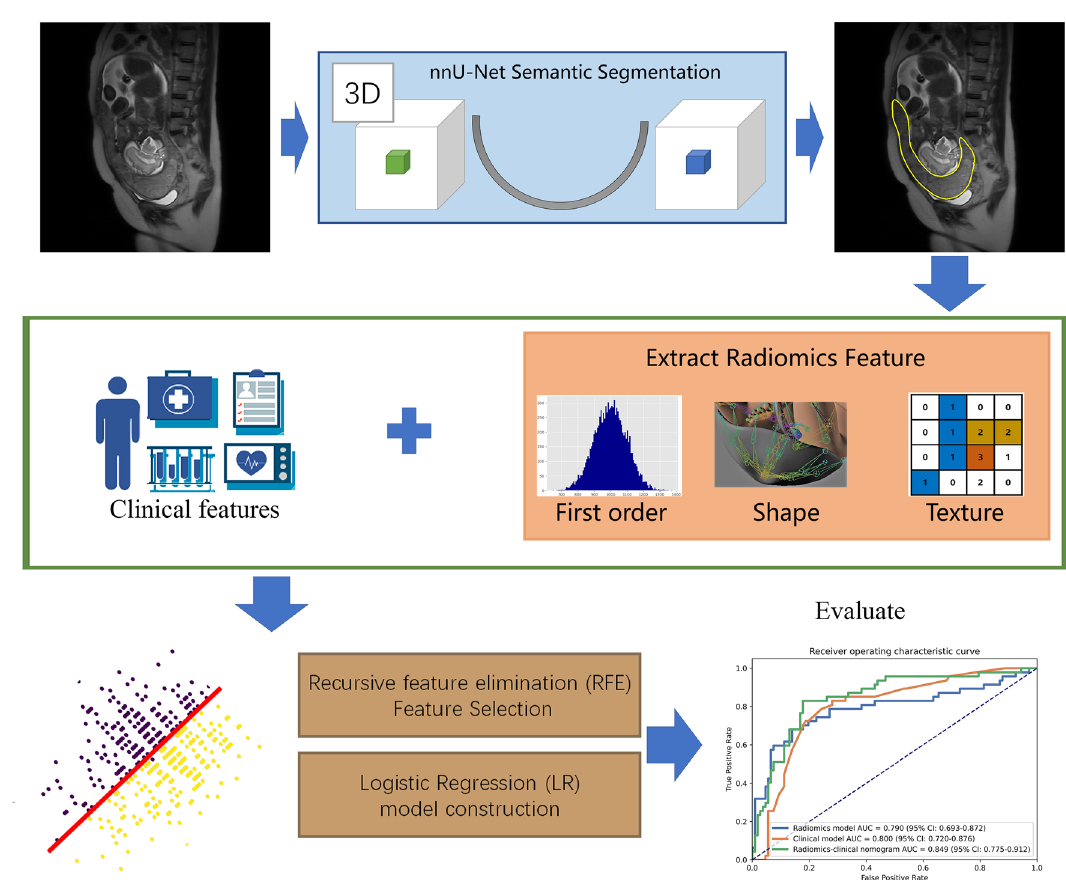
Figure 2. A trained nnU-Net model was utilized to automatically segment placenta region on sagittal T2WI. The radiomics features were extracted from the segmented region and combined with clinical features to build a machine learning model for prediction of PAS